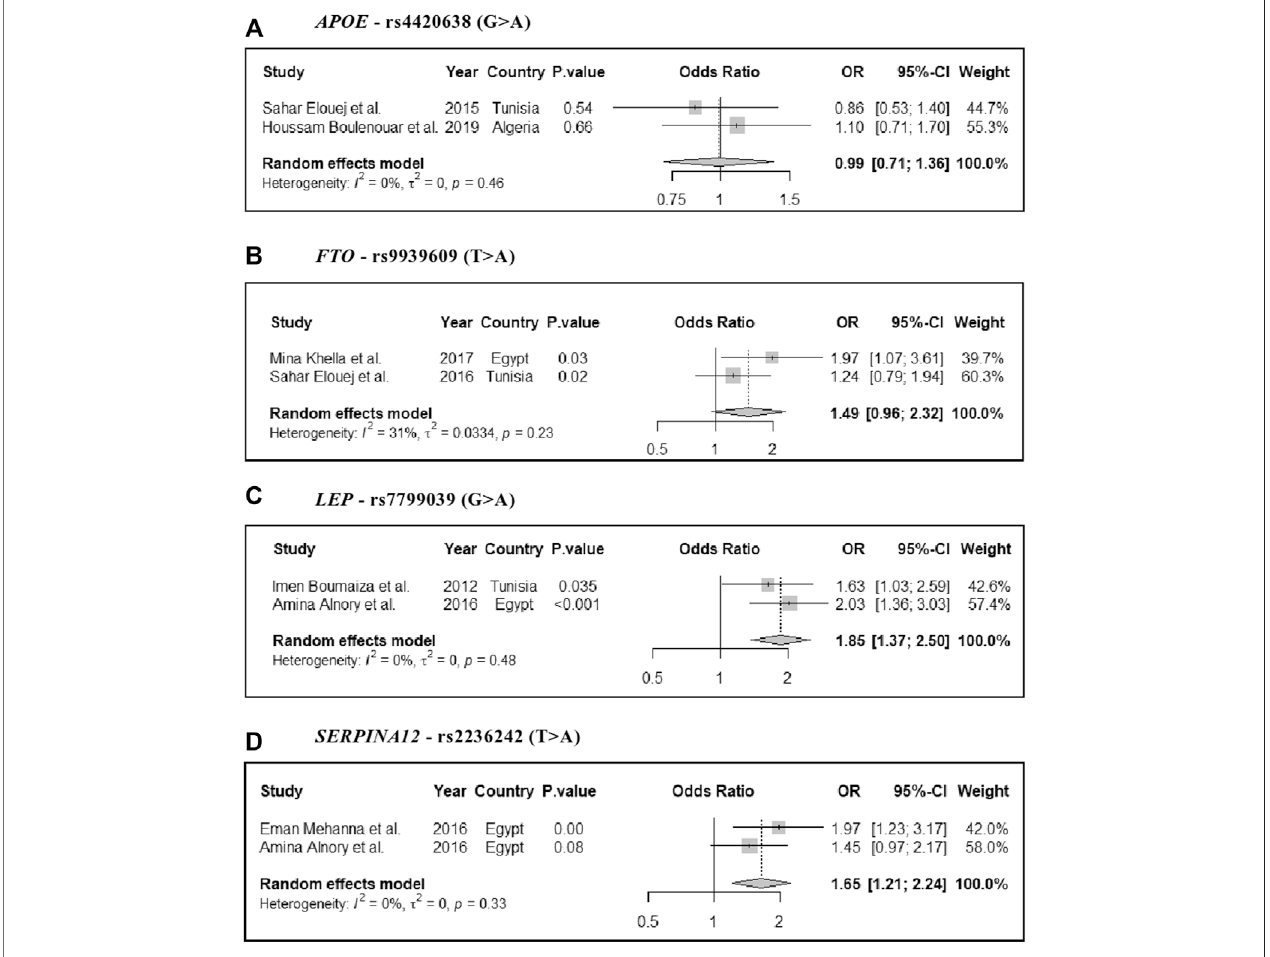
FIGURE 2 | Forest plot of the pooled odds ratios and 95% CI estimates of MetS for four genetic markers: (A) APOE - rs4420638 (G > A), (B) FTO - rs9939609 (T > A), (C) LEP - rs7799039 (G > A), and (D) SERPINA12 - rs2236242 (T > A).